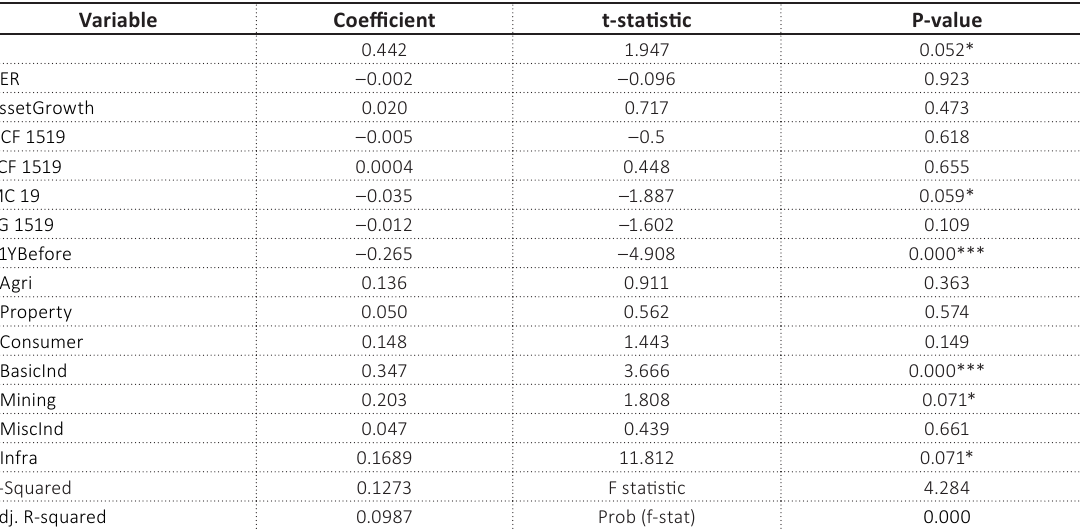
Table 5. Regression model 2